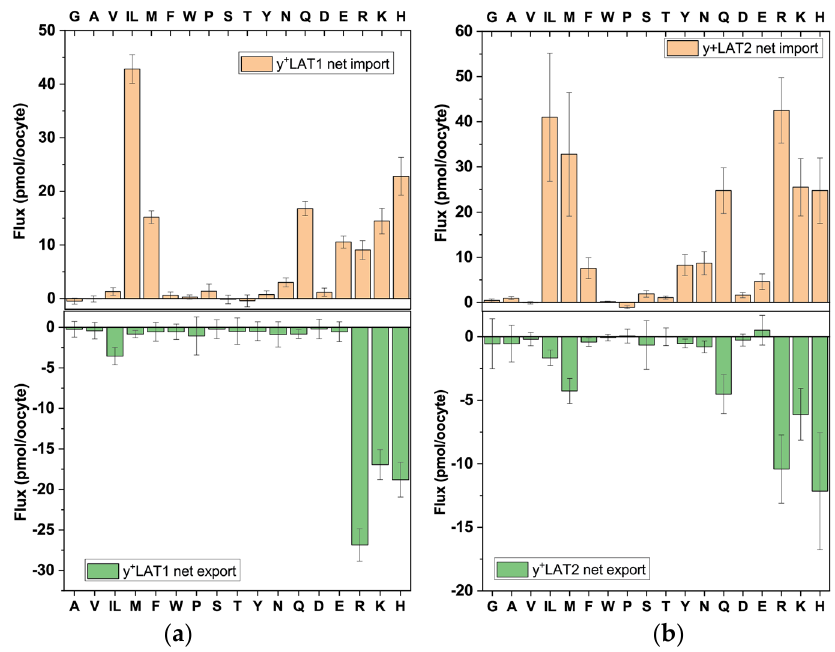
Figure 5. Analysis of antiport via y + LAT1 and y + LAT2 . Oocytes expressing 4F2hc–y + LAT1 ( a ) or 4F2hc–y + LAT2 ( b ) were incubated with labelled and unlabelled amino acids as described in Figure 2a. Net import (positive numbers) and net export (negative numbers) are shown. Isoleucine and leucine cannot be separated by LC–MS and are shown as IL.